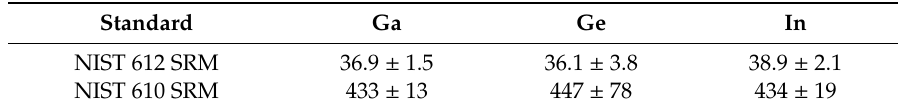
Table 2. Internal concentrations of Ga, Ge and In in the external standards used in the LA-ICP-MS measurements